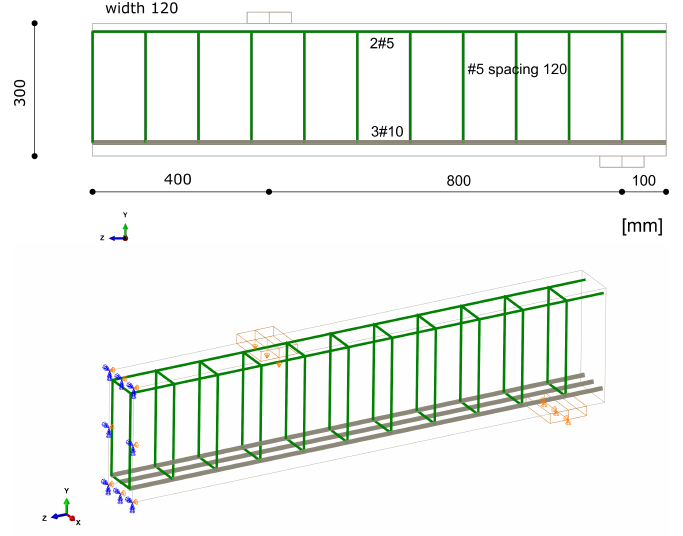
Figure 15. Beam failure in bending—dimensions and boundary conditions assumed in the